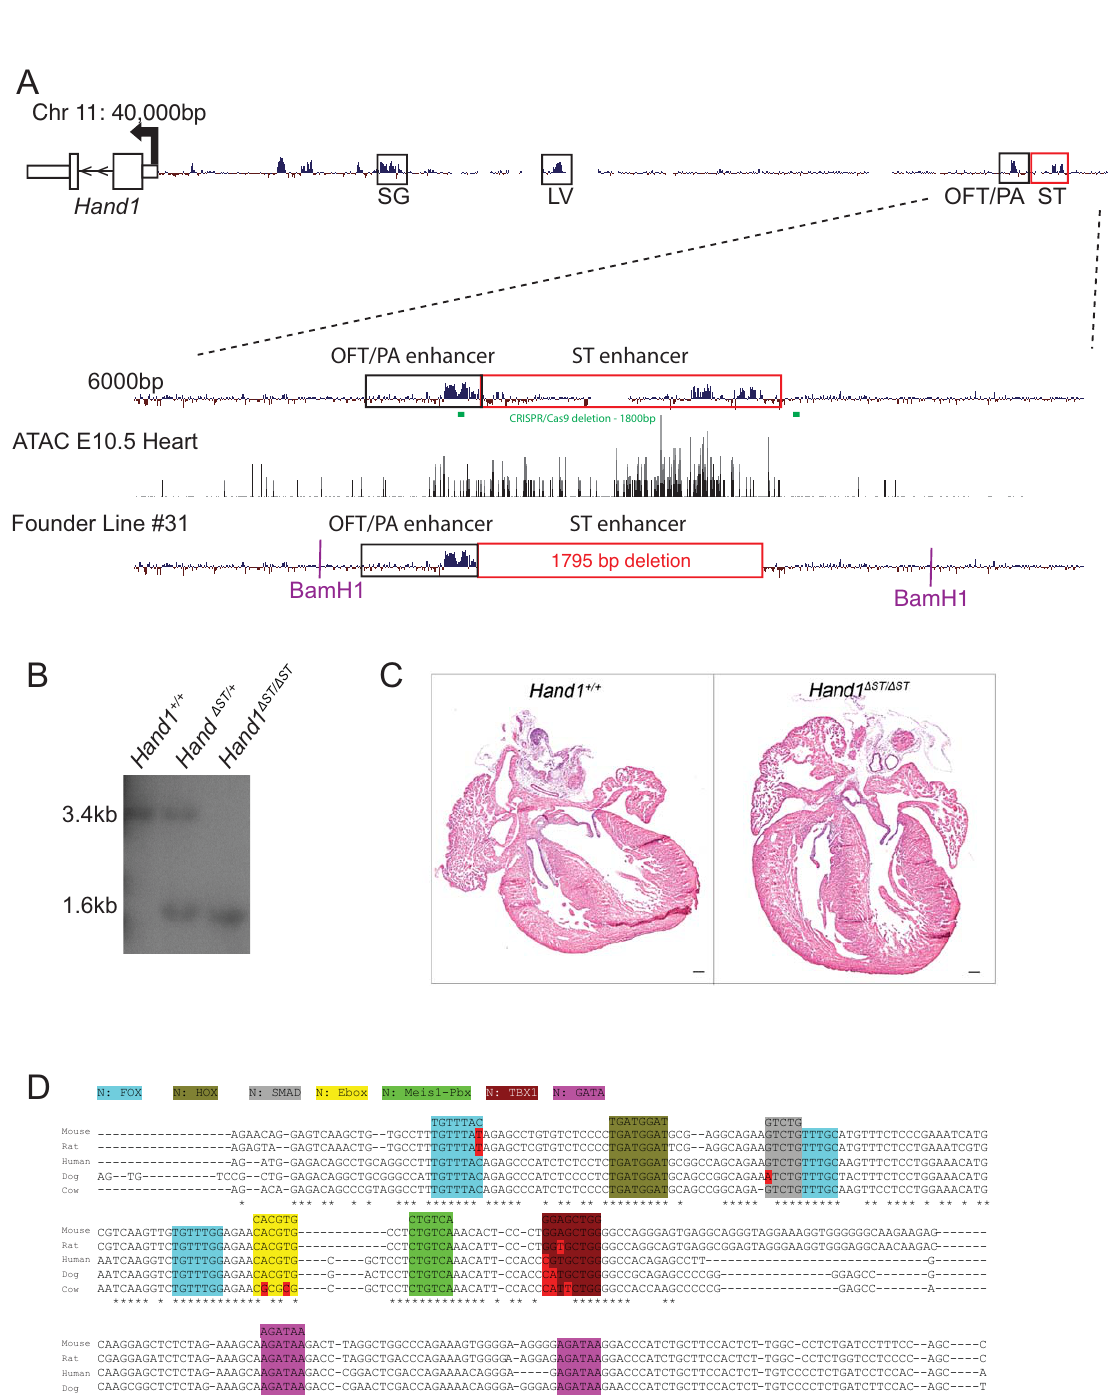
Figure 1. CRISPR/Cas9 mediated deletion of ST enhancer. ( A ) Mammalian conservation track at the mouse Hand1 locus. Conserved non-coding regions with spatial and temporal specific activity are boxed. ST enhancer is boxed in red. Close up region of OFT and ST enhancer are indicated with overlying ATAC-seq from E10.5 hearts. Bars in green represent guide RNA sequences designed for CRISPR/Cas9 mediated deletion of ST enhancer. The largest deletion line used for further analysis with 1795 bp deletion is shown. Representative BamH1 digest sites for Southern blot analysis are indicated. Location of Southern blot probe is indicated. ( B ) Southern blot analysis for genotyping Hand1 ∆ ST/ ∆ ST . Wildtype Hand1 +/+ , Heterozygote Hand1 ∆ ST/+ , and Homozygote Hand1 ∆ ST/ ∆ ST are shown. The Hand1 + allele is 3.6 kb in length and the Hand1 ∆ ST allele is 1.6 kb in length. ( C ) Post-natal day 1 hearts from Hand1 +/+ Hand1 ∆ ST/ ∆ ST mice. 10 µ m wax sections are stained with hemotoxylin and eosin. Scale bar 100 µ m. ( D ) ClustalW pile up for core conserved region of ST enhancer comparing mouse, rat, human, cow, and dog sequences. Consensus DNA sequence for transcription factor binding sites is indicated. LV, left ventricle; OFT, outflow tract; PA, pharyngeal arches; SG, sympathetic ganglia; ST, septum transversum; ATAC-seq, assay for transposase-accessible chromatin using